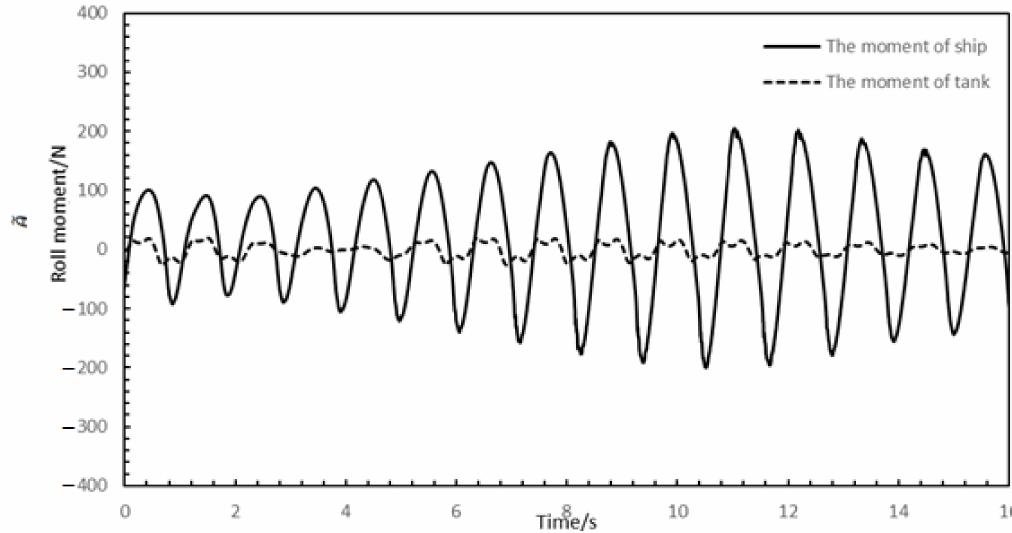
Figure 15. Rolling moment of the ship and tank (the height of liquid in the tank is 0.1 m) when the wavelength ratio is 0.463.